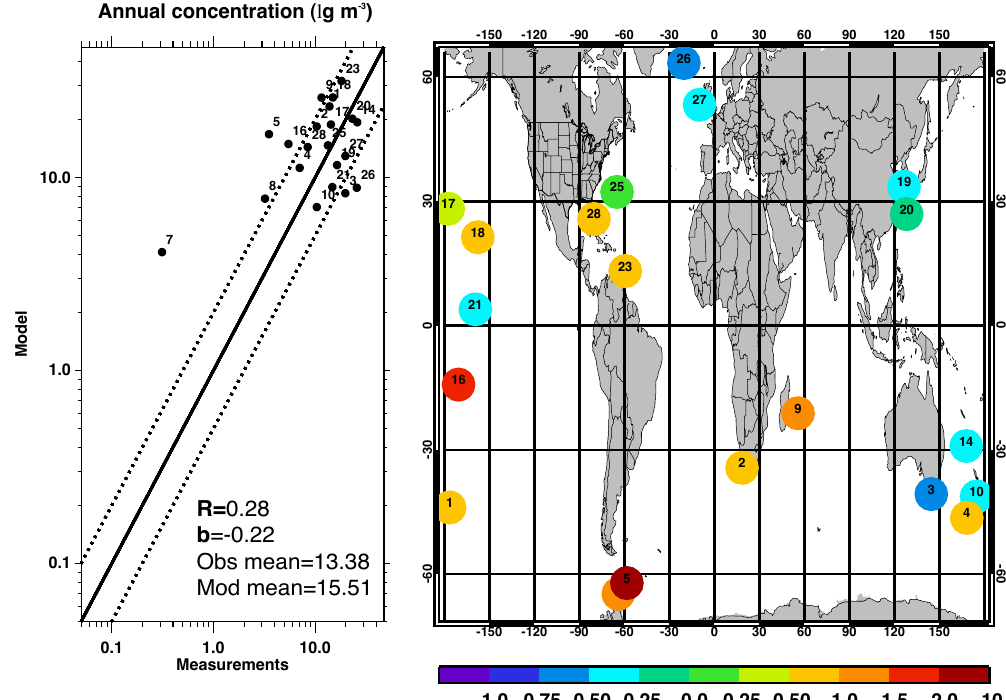
Relative difference of annual SeaSalt [ug/m3] conc with RSMAS Figure 13